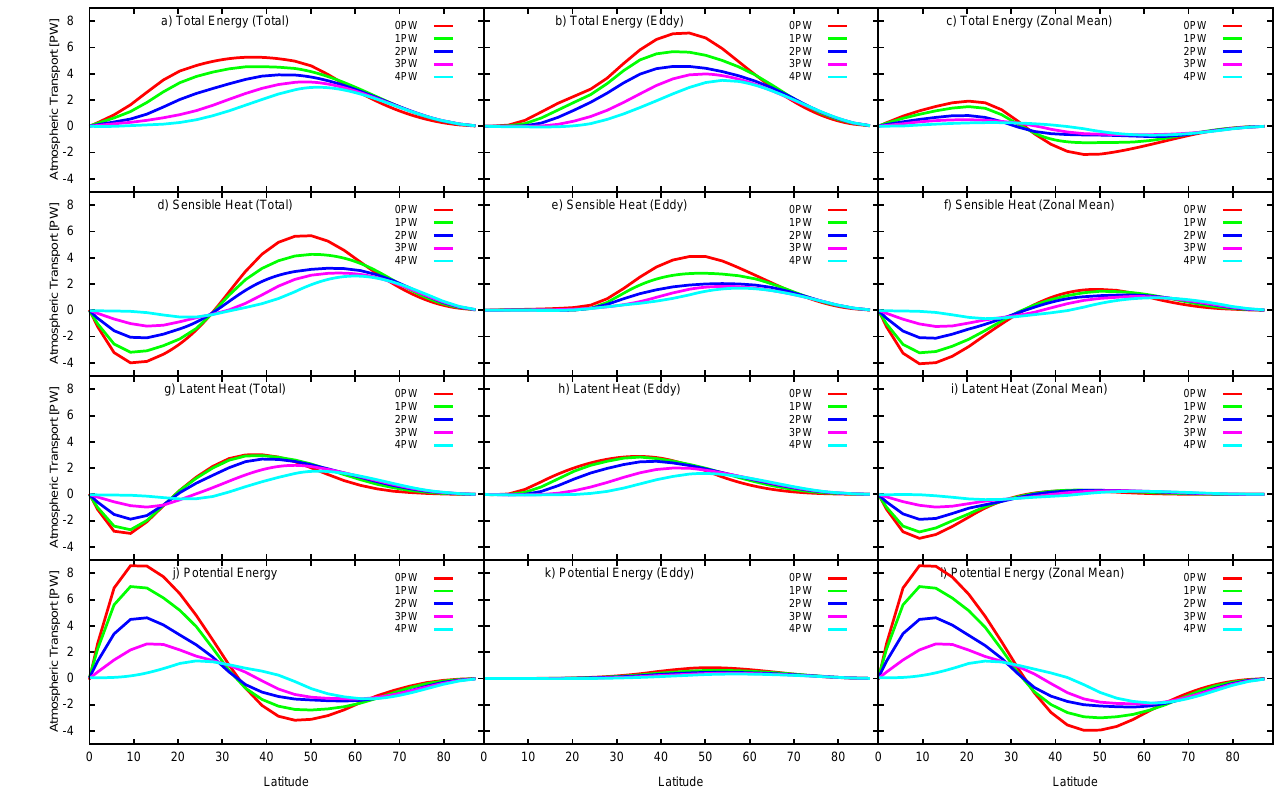
Figure 11. Atmospheric heat (moist static energy) transport (in PW) assigned to different processes for OHT max = 0, 1, 2, 3, and 4PW.